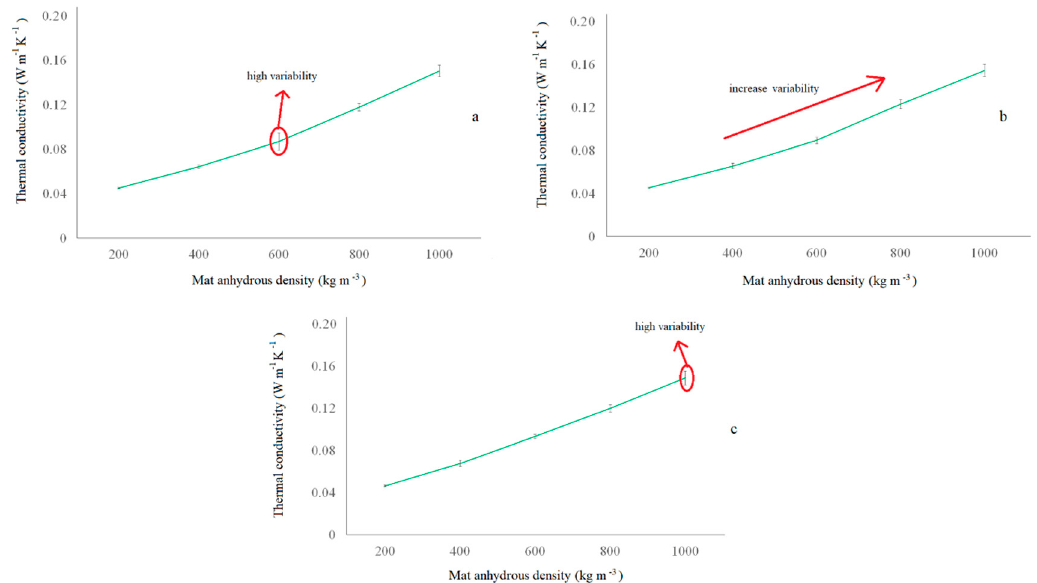
Figure 12. Thermal conductivity versus mat anhydrous density for different fiber sizes: ( a ) Fine size, ( b ) medium size, ( c ) coarse size. Vertical lines show error bars.